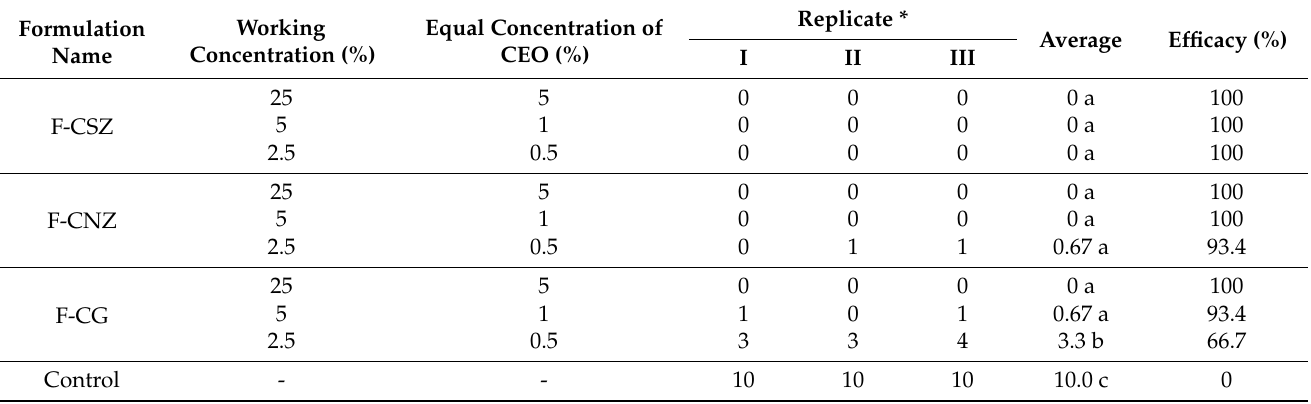
Table 5. Efficacy of encapsulated CEO formulations used on raspberry fruits against B. cinerea